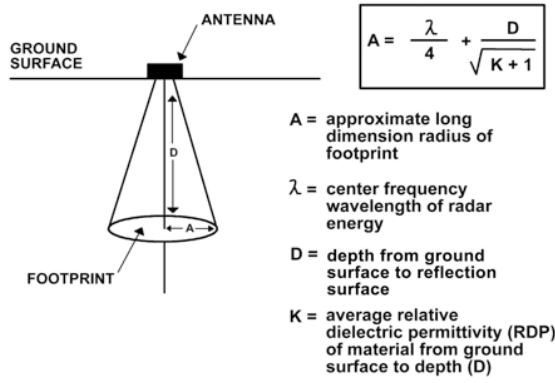
Figure 6. Radar energy cone of transmission and